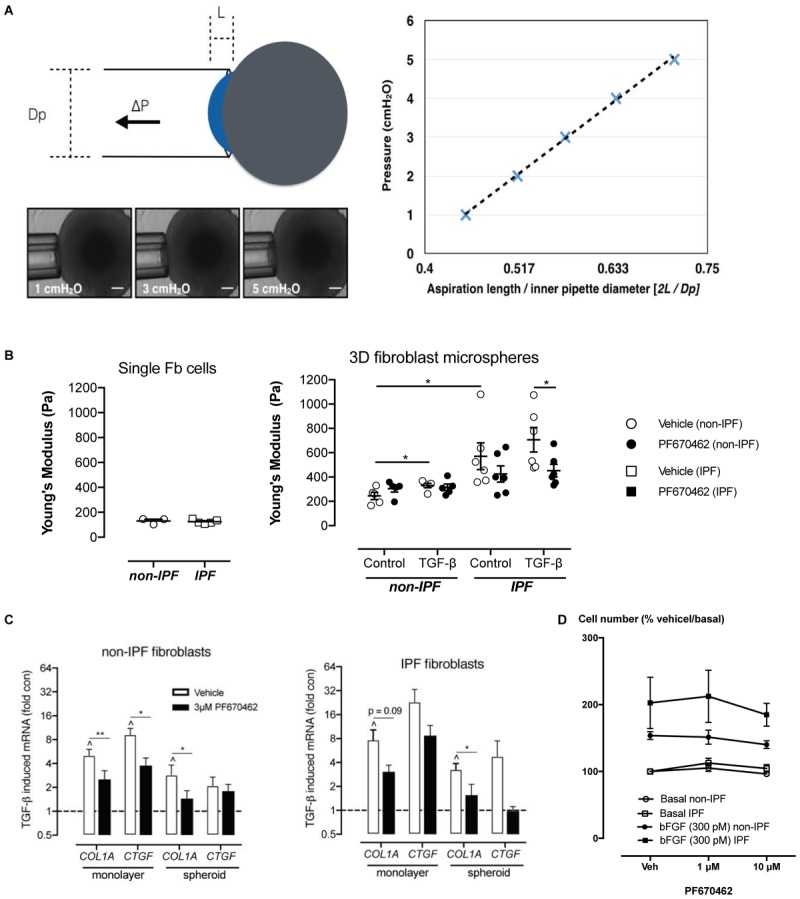
(A) Measurement of Young’s modulus. With increasing pressure (P) the spheroid travels a distance (L) through the micropipette barrel of inner diameter (Dp). A representative spheroid is shown with aspiration at 3 different pressures. The normalized distance (2L/Dp) is linearly related to the applied pressure and the slope of the linear regression defines the Young’s modulus. Scale bars indicate 100 μm. (B) Spheroid stiffness was measured by micropipette aspiration and quantified to measure the Young’s Modulus of stiffness in single cells (non-IPF, n = 3; IPF, n = 5) and in spheroids (non-IPF, n = 6; IPF, n = 6). (C) The effects of PF670462 on TGF-β (100 pM)-induced COL1A and CTGF mRNA expression from pFb monolayers and spheroids from IPF and non-IPF pFbs are presented as the means and SEM of (for monolayer expression: non-IPF, n = 3; IPF, n = 5) and (for spheroid expression: non-IPF, n = 9; IPF, n = 6). (D) Cell number expressed as a percentage of the basal cell number in the presence and absence of vehicle (Veh) or PF670462 in cells from non-IPF or IPF donors in the presence and absence of the mitogen, bFGF (n = 6). ∗P < 0.05, ∗∗P < 0.01 from two-way ANOVA with Bonferroni post hoc test or 1-way ANOVA with Dunnet’s post hoc test. ∧P < 0.05 from one-sample t-test compared to 1.0.